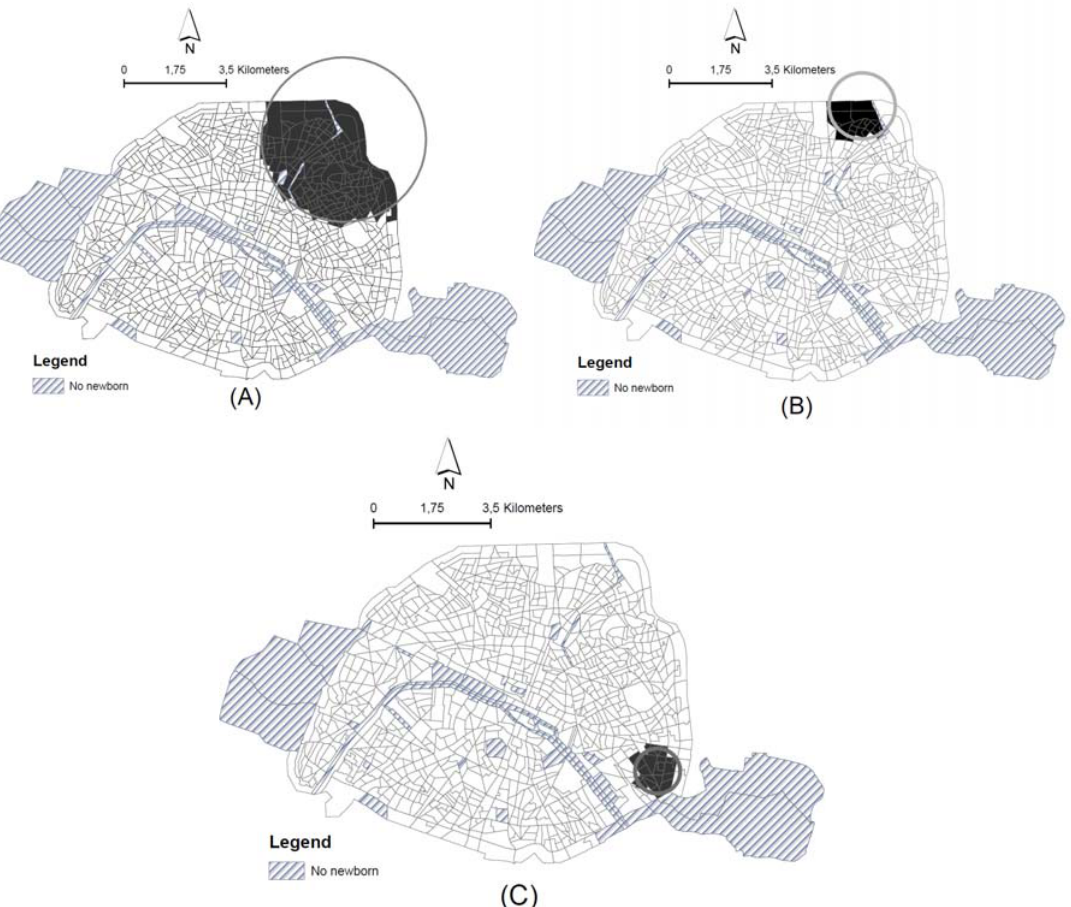
Figure 2. Spatial relocation of the most likely cluster of unadjusted PTB risk ( A ); after adjustment for NO 2 exposure ( B ); after adjustment for NO 2 exposure and socio ‐ economic level ( C ). Legend: the dark area represents the census blocks included in the most likely cluster of high risk of PTB.